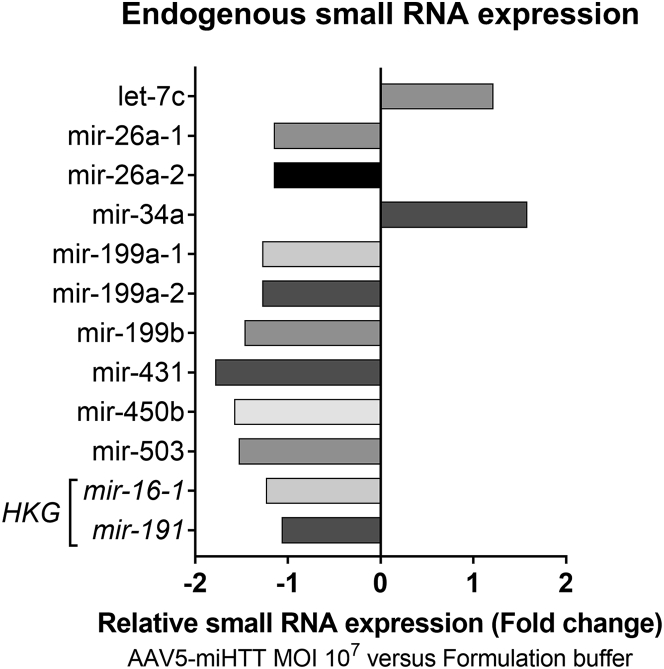
Small RNA Sequencing Analysis of AAV5-miHTT-Treated HD71 iPSC-Derived Neuronal CultureHD71 patient iPSC-derived neuronal culture was transduced with AAV5-miHTT at a MOI of 107 (n = 4) and formulation buffer (n = 4) as control. Ten days after transduction, RNA was isolated and small RNA sequencing was performed. The reads were aligned to the human reference sequence. The small RNA reads of the AAV5-miHTT-treated samples were compared to the reads of the control samples (treated with formulation buffer-treated) to obtain the relative expression of endogenous small RNAs of treated versus control samples (cut-off false discovery rate p value <0.05). Relative expression was calculated and expressed as fold change compared with controls.